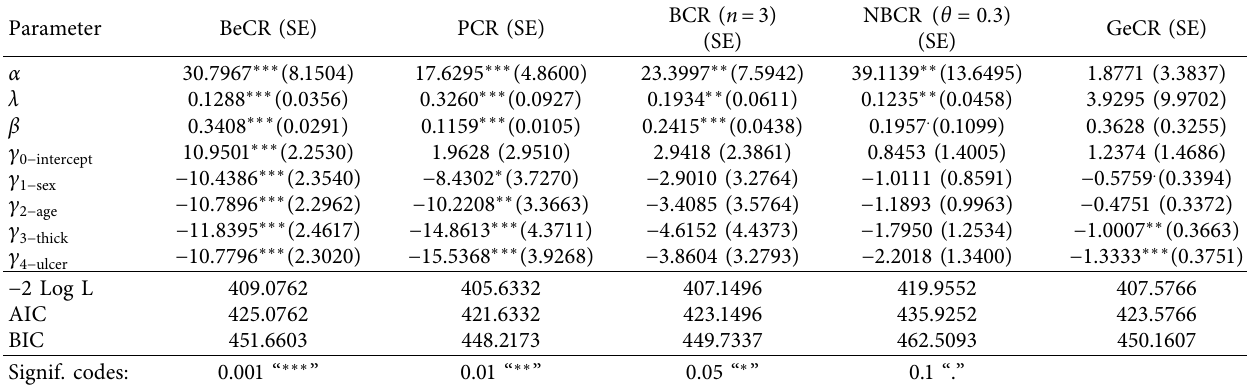
Table 2: ML estimators, standard errors (SEs), and information criteria for the melanoma cancer data set for diferent models.